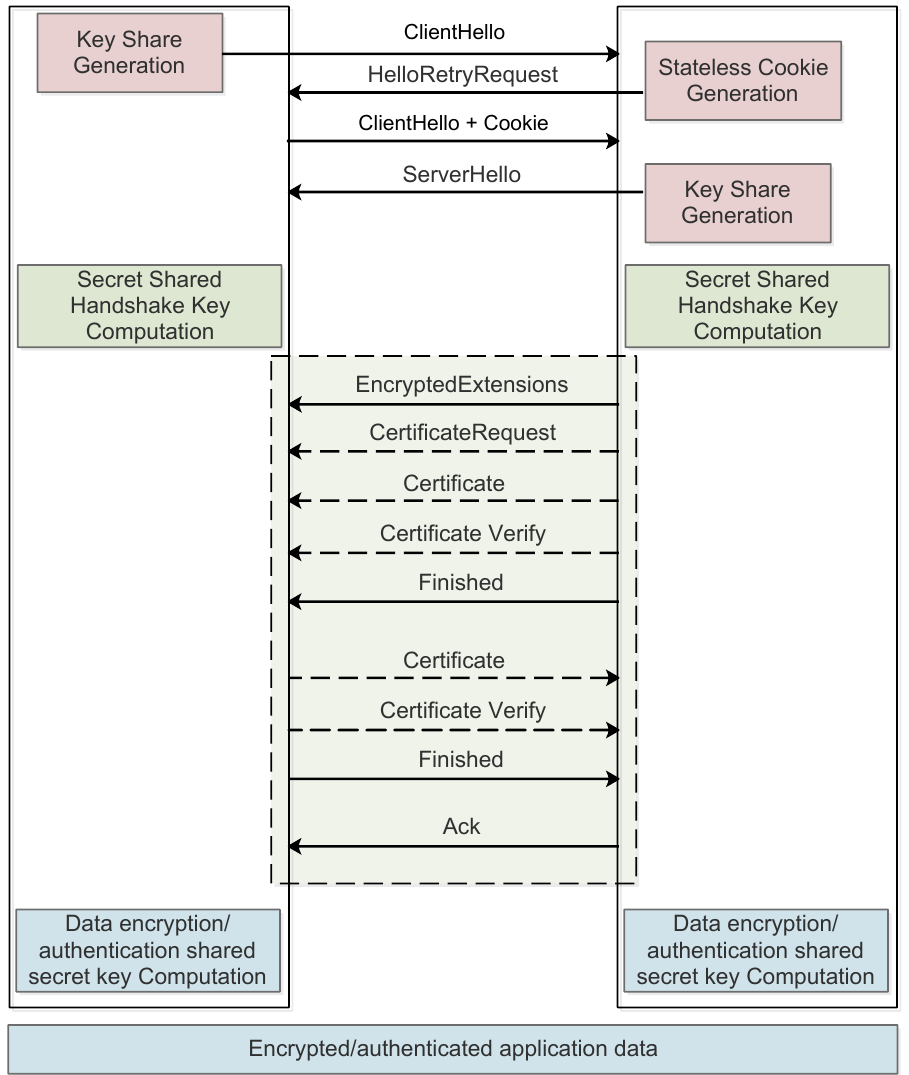
Figure 3. Message exchange of the DTLS 1.3 handshake